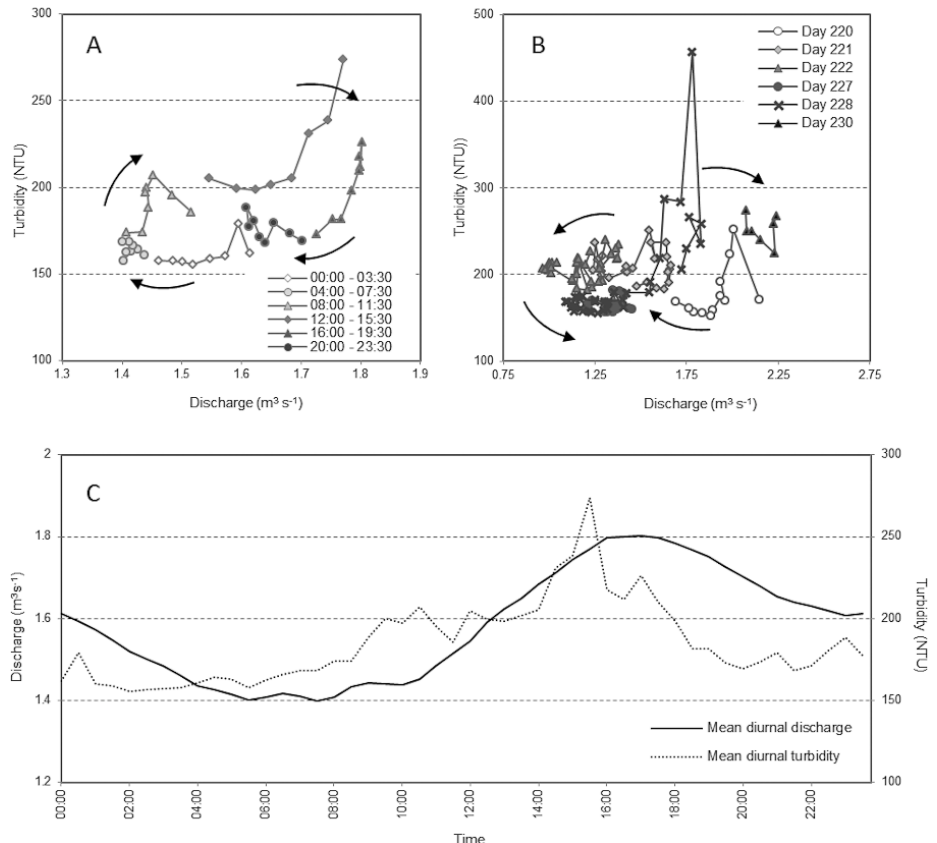
Figure 4. (a) Diurnal turbidity, averaged at 30min intervals across all measurement days, plotted against mean diurnal discharge, (b) all available measurements of turbidity (30min intervals) plotted against discharge, and (c) diurnal cycle of discharge and turbidity averaged at 30min intervals for all available measurements between days 220 and